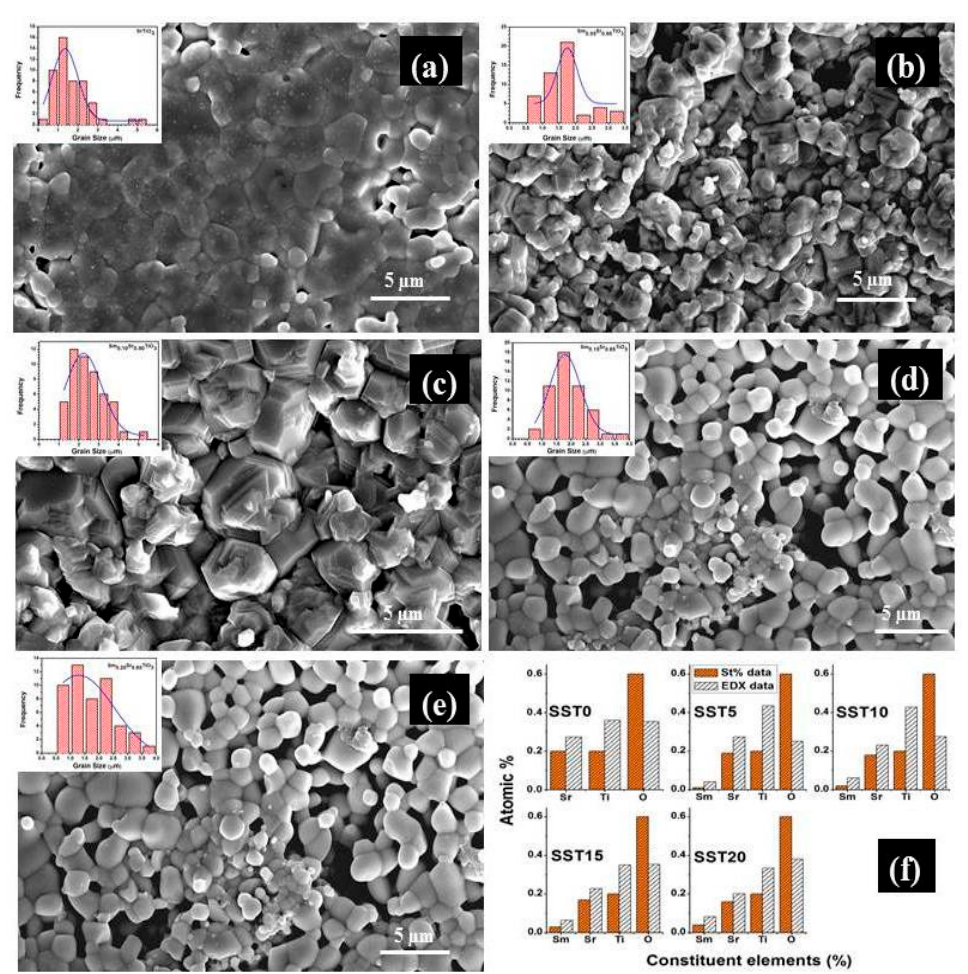
Figure 4. The FESEM micrographs of the fractured samples sintered at 1200 °C in air ( a ) SST0, ( b ) SST5, ( c ) SST10, ( d ) SST15, ( e ) SST20 and ( f ) The stoichiometric and EDX at% for the samples.